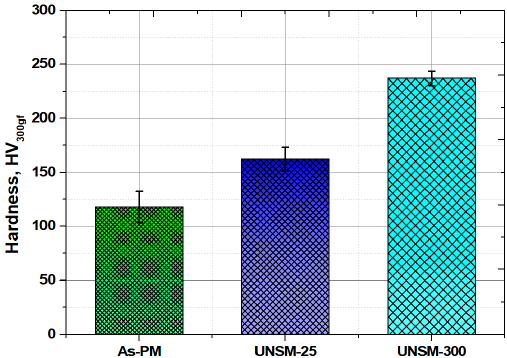
Figure 6. Comparison in surface hardness of the as-PM, UNSM-25 and UNSM-300 samples.